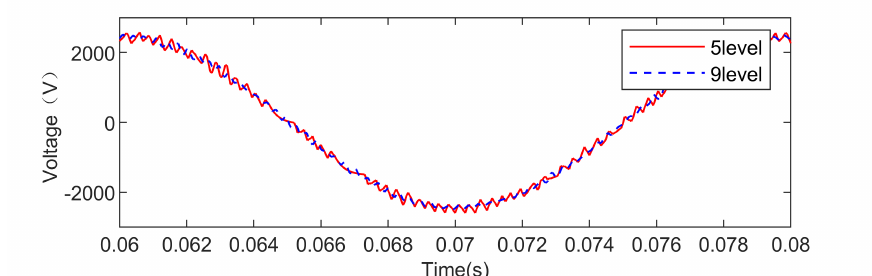
Figure 12. Output voltage ( u oa )